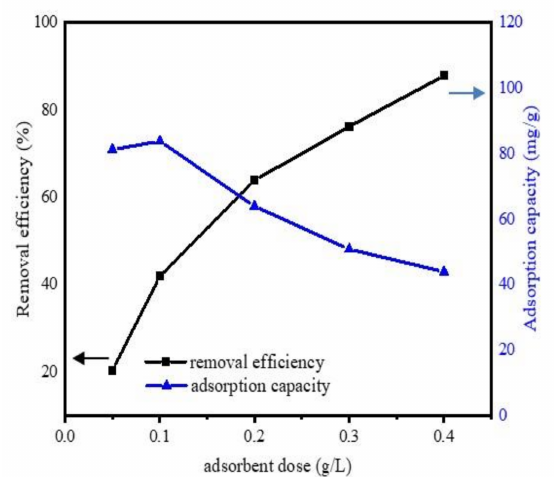
Figure 7. E ff ects of adsorbent dosage on the uptake of DCF onto Fe@BC.